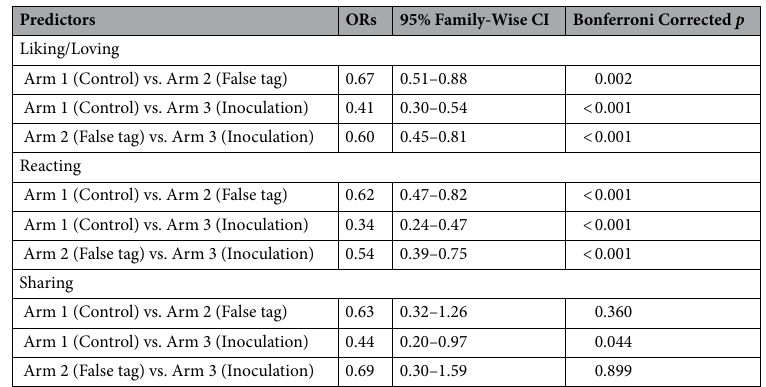
Table 3. Comparisons testing the performance of experimental arms in reducing engagement with misinformation, per model and outcome (p-value adjusted to account for multiple comparisons).